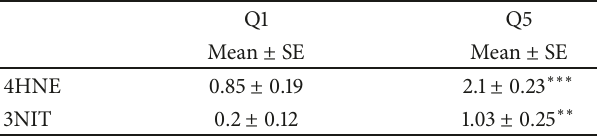
Table 4: Immunohistochemistry